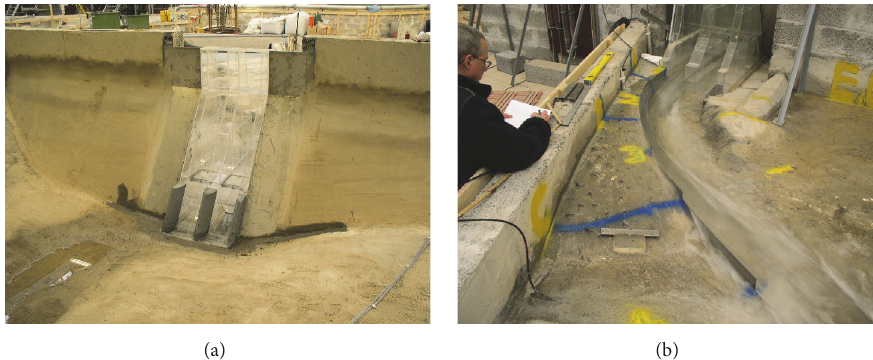
Figure 5: Physical hydraulic model of the bottom outlet. (a) Upstream view; (b) downstream view with free outflow.